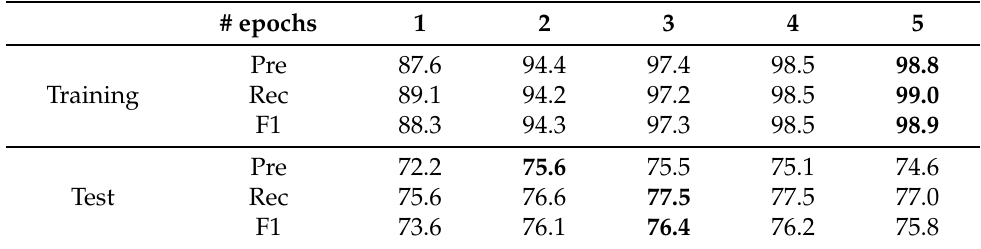
Table 4. Training epochs vs. performance. The highest value of each metric is marked in